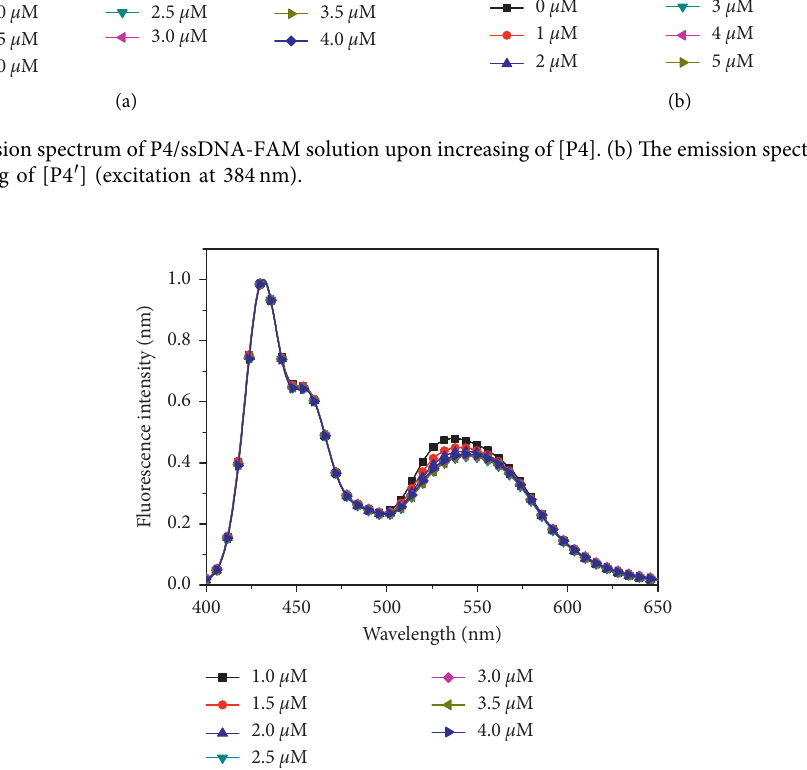
Figure 11: The normalized emission spectrum of P4/ssDNA-FAM solution upon increasing of